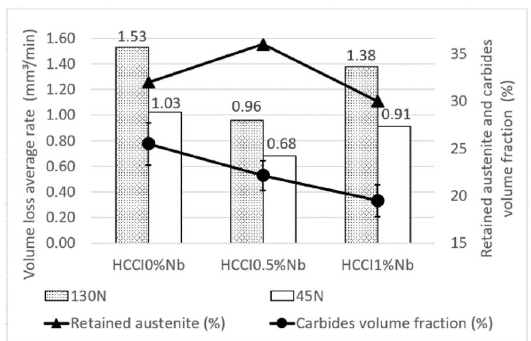
Figure 12. The relationship between wear rates, CVF and retained austenite in